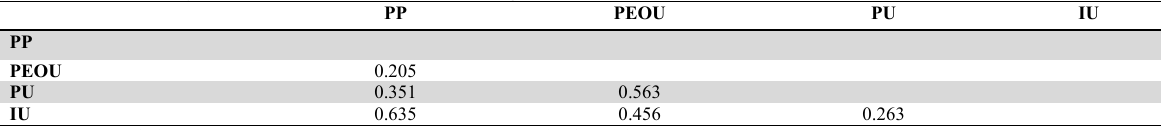
Discriminant validity for the measurement model using (HTMT).